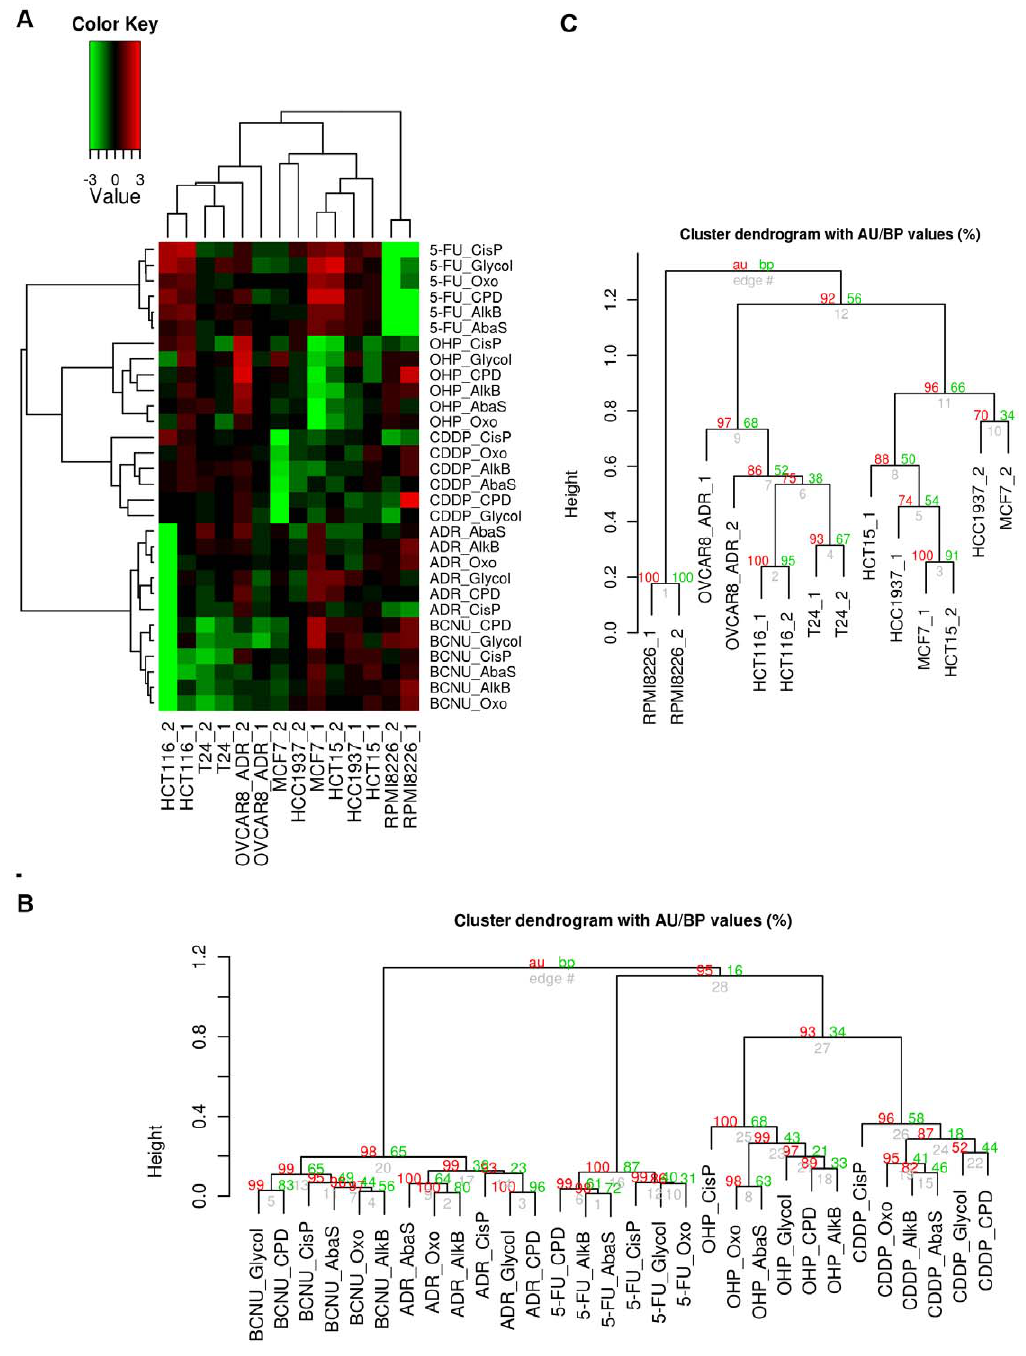
Figure 2. Analysis of the DNA repair response of the cell lines across treatments and lesion types. A. The heatmap was constructed using the log2 transformed ratios of the fluorescence intensity obtained for repair of each lesion between treated and non-treated cell lines (log2(T/ NT)). Hierarchical clustering algorithm with correlation dissimilarity measure was used to group in a colour-coded grid the seven cell lines from the two experiments and the five treatments by lesion type repair, in the two dimensions. In the first dimension, cell lines were clustered by similarity of their DNA repair response profile covariation across the impact of the five treatments by lesion type repair. In the second dimension, treatments by lesiontyperepair wereclustered bysimilarity oftheir patterncovariationacrossthe sevencelllines fromthe two experiments.Toevaluatethe consistency between the two independent experiments, Set_1 and Set_2 data were kept separated and analyzed simultaneously (marked _1 and _2 respectively). In the colour-coded grid, values greater than 0 are shaded in red indicating stimulation of repair activities whereas values below 0 are coloured in green indicating an inhibition of repair activities, compared to NT cells. Values greater than 0 were shaded in red indicating stimulation of repair activity, while values below 0 were shaded in green indicating inhibition of repair activity. Values around 0 were coloured in black indicating no detected effect. Brightness of colour was correlated with the magnitude of effect of treatments on the DNA repair activities. B. Dendrogram of the five treatments by lesion type repair with clusters significance values. C. Dendrogram of the seven cell lines from the two experiments with clusters significance values. P- values (AU (Approximately Unbiased) P value in red and BP (Bootstrap Probability) P value in green) are reported on the dendrograms.